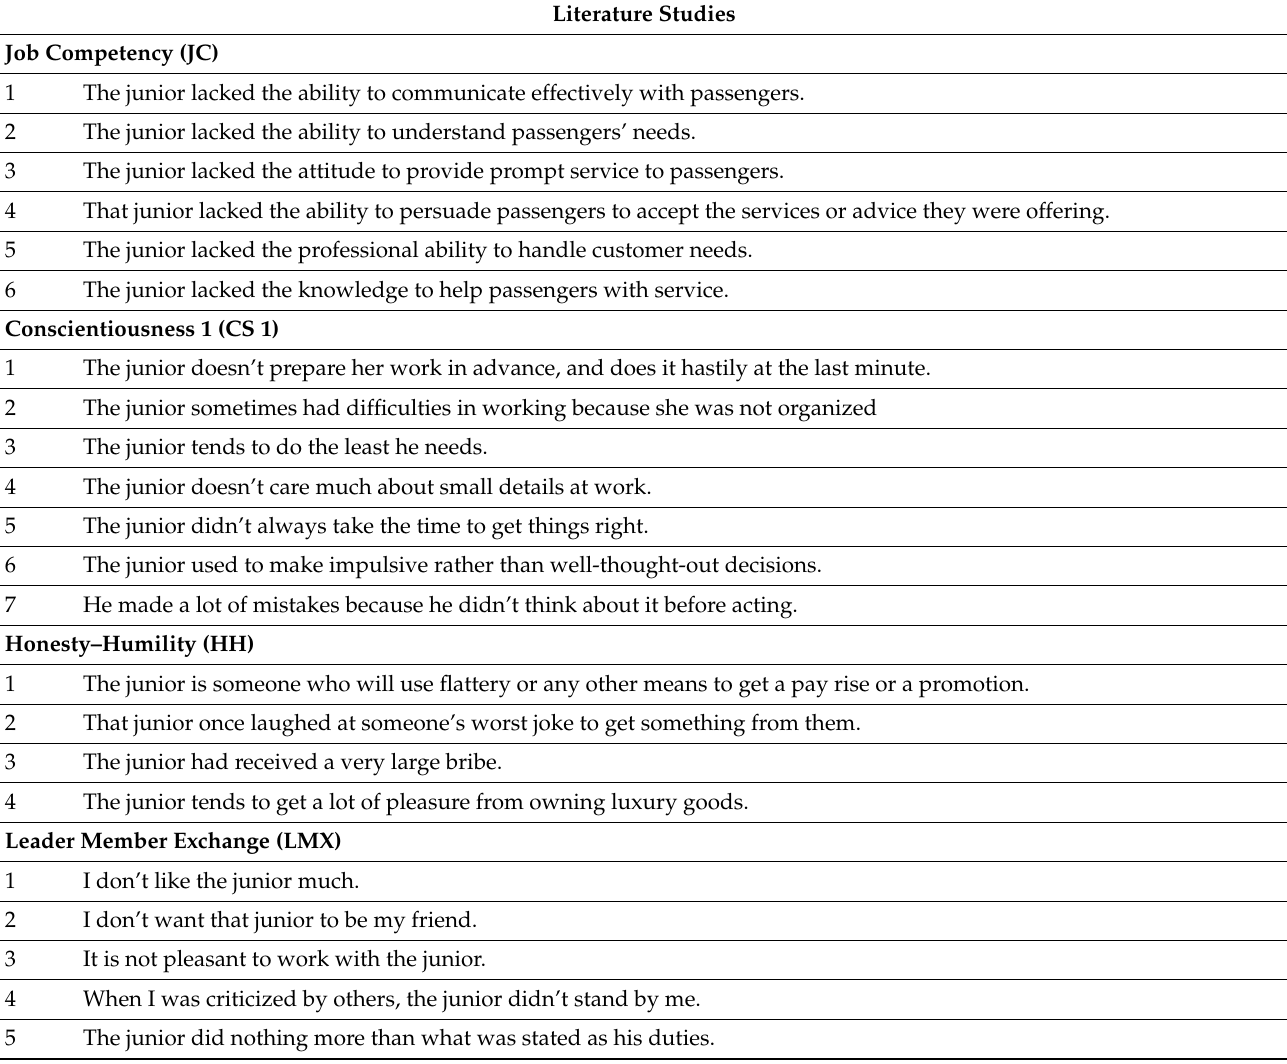
Table 1. Comparison of initial items construct (literature studies vs. in-depth interviews) Literature